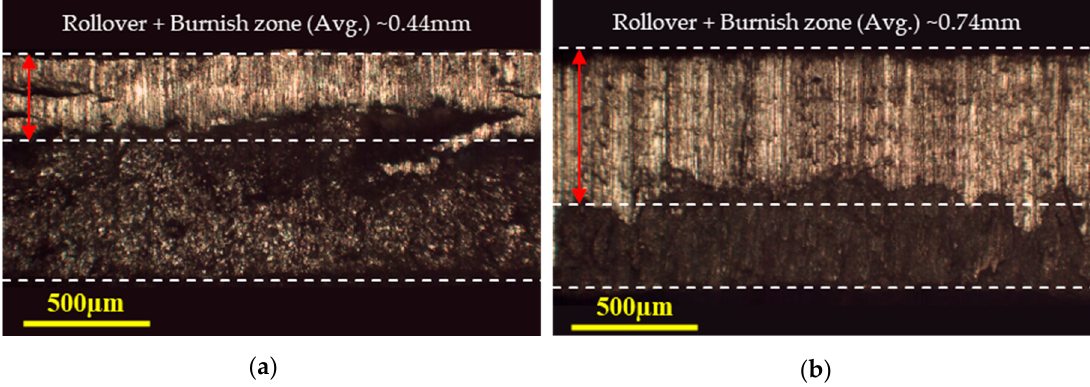
Figure 5. Front view (OM) of the blanked edge obtained from experiments for 20% clearance at ( a ) 25 °C, indicating micro-cracks in the burnish zone and loose fragments, and ( b ) 250 °C, indicating positively improved sheared edge. The rollover depth was measured as the vertical distance between the upper plane of the workpiece and the onset of the burnish zone. It was observed that the rollover depth increases with the increase in temperature and punch–die clearance. The rollover depth at 10% clearance increased from approximately 0.1 mm at ambient temperature to approximately 0.18 mm at 250 °C. Similarly, at 30% clearance and 250 °C, the rollover depth increased up to approximately 0.25 mm. Increase in temperature (increase ductility) and clearance (wider processing zone) delayed punch penetration of